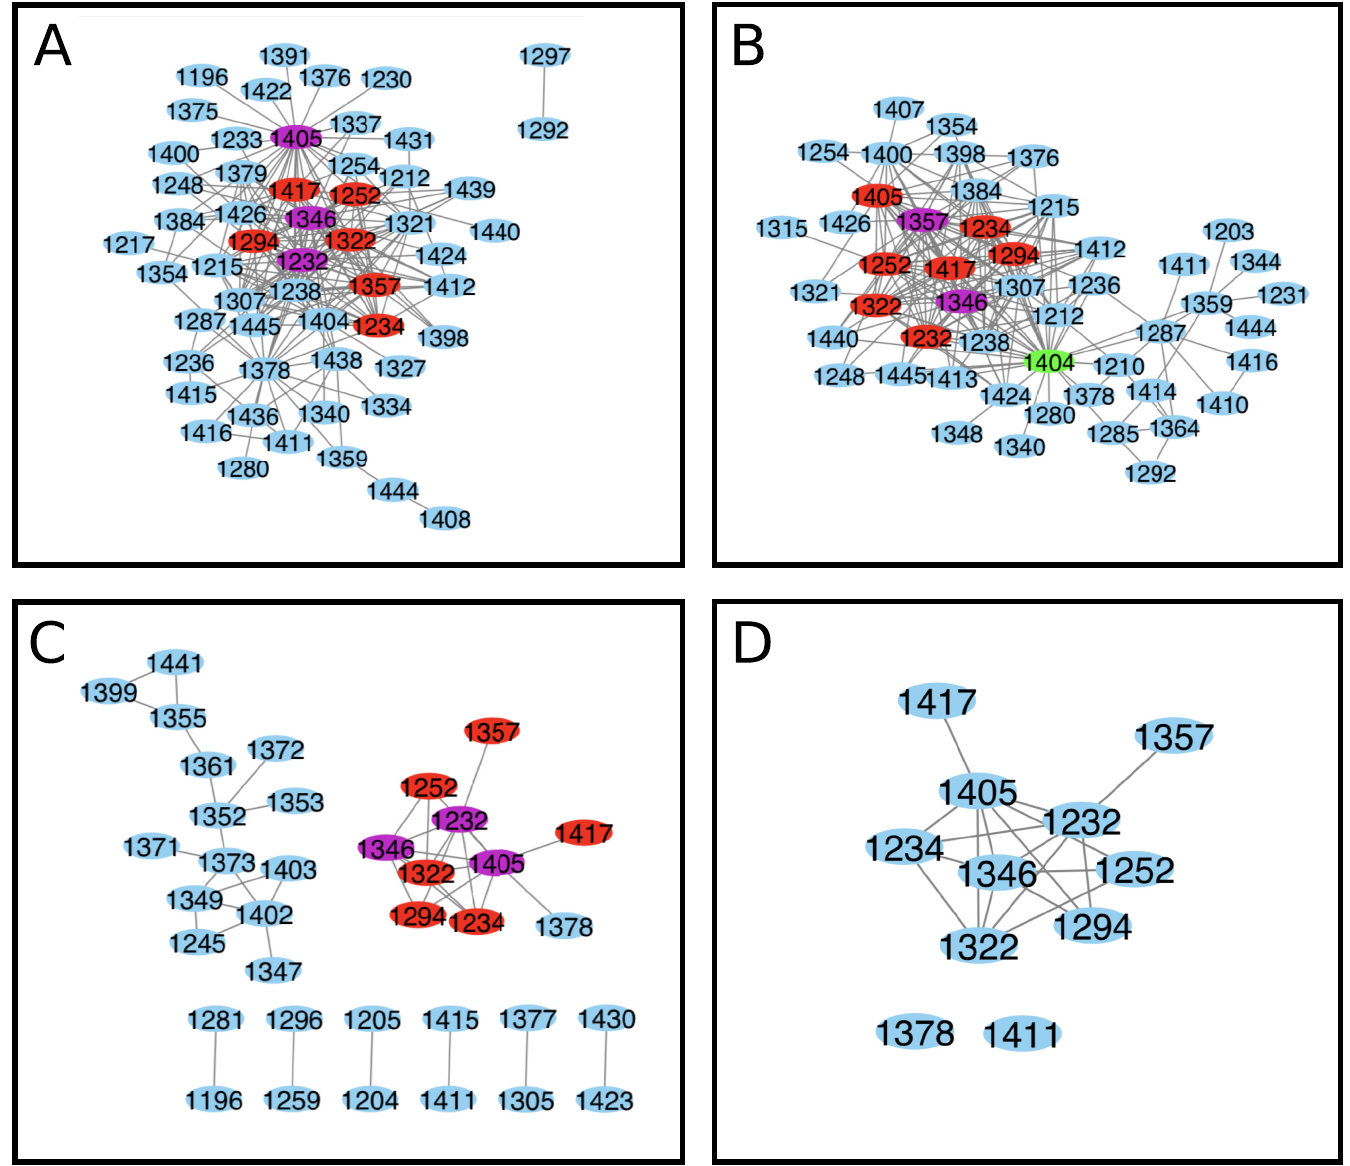
Fig 4. NBD2 Cytoscape interaction map for S1251T perturbation analysis. (A) ELSC (S1251T) coupling matrix (B) OMES (S1251T) coupling matrix (C) McBASC (S1251T) coupling matrix (D) Composite of ELSC, OMES, and (S1251T) analyses. The composite map was generated from the individual maps using the top 200 coupled positions that were common to all analyses (ELSC, OMES, McBASC) using Cytoscape software. Nodes that are central and overlap in all analysis are colored purple. Nodes that overlap in all analysis are colored red, and central nodes are colored